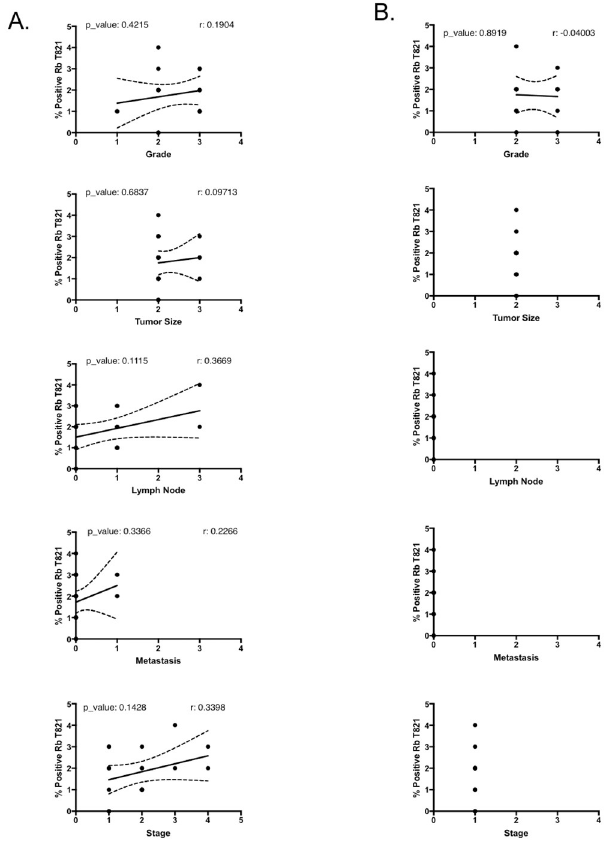
Fig 7. Rb T821 phosphorylation did not correlate with any of clinical parameter. Correlation coefficient analyses to determine whether in the SCC (A) or in the AC subtypes (B), the IHC score for Rb phosphorylation on T821 correlates with any of the clinical parameters accompanying the tumor samples in the